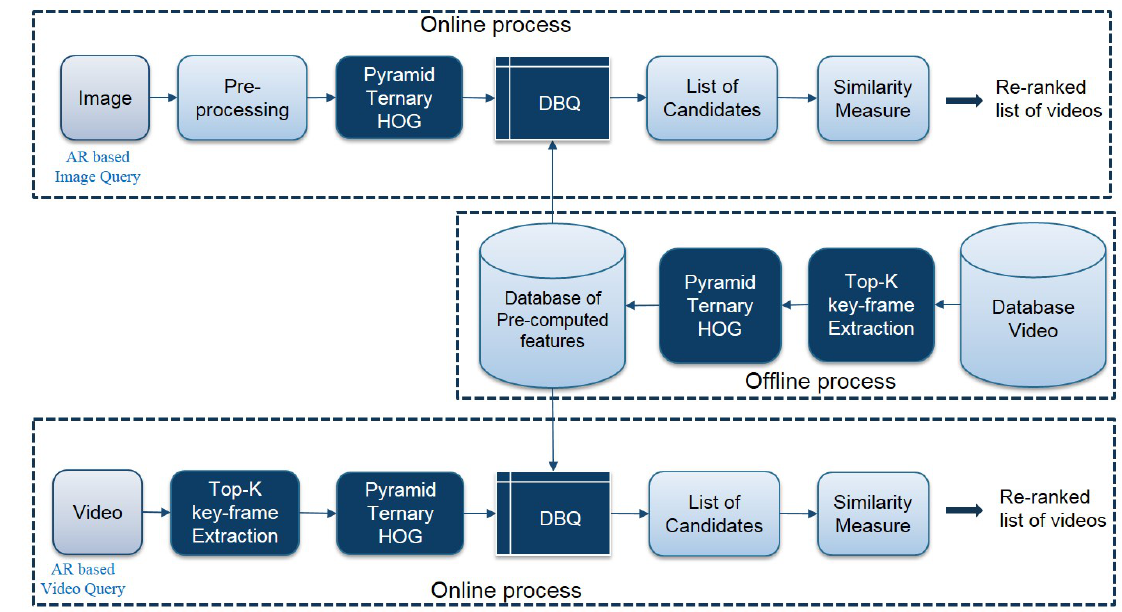
Figure 2. A detailed scenario for video retrieval on